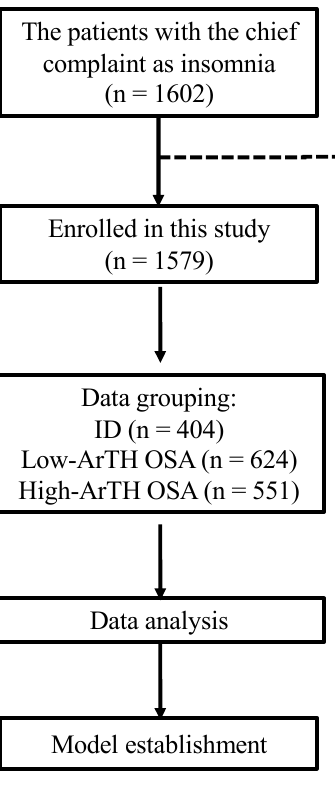
Figure 1. Flowchart of the data collection in the study. The data collection procedure involved included and excluded criteria and eligible data amounts. The data of 1602 patients reporting insomnia as their chief complaint were collected, and 1579 of them were eligible for further analysis. Abbreviation: ID: insomnia disorder; ArTH: respiratory arousal threshold; OSA: obstructive sleep apnea.